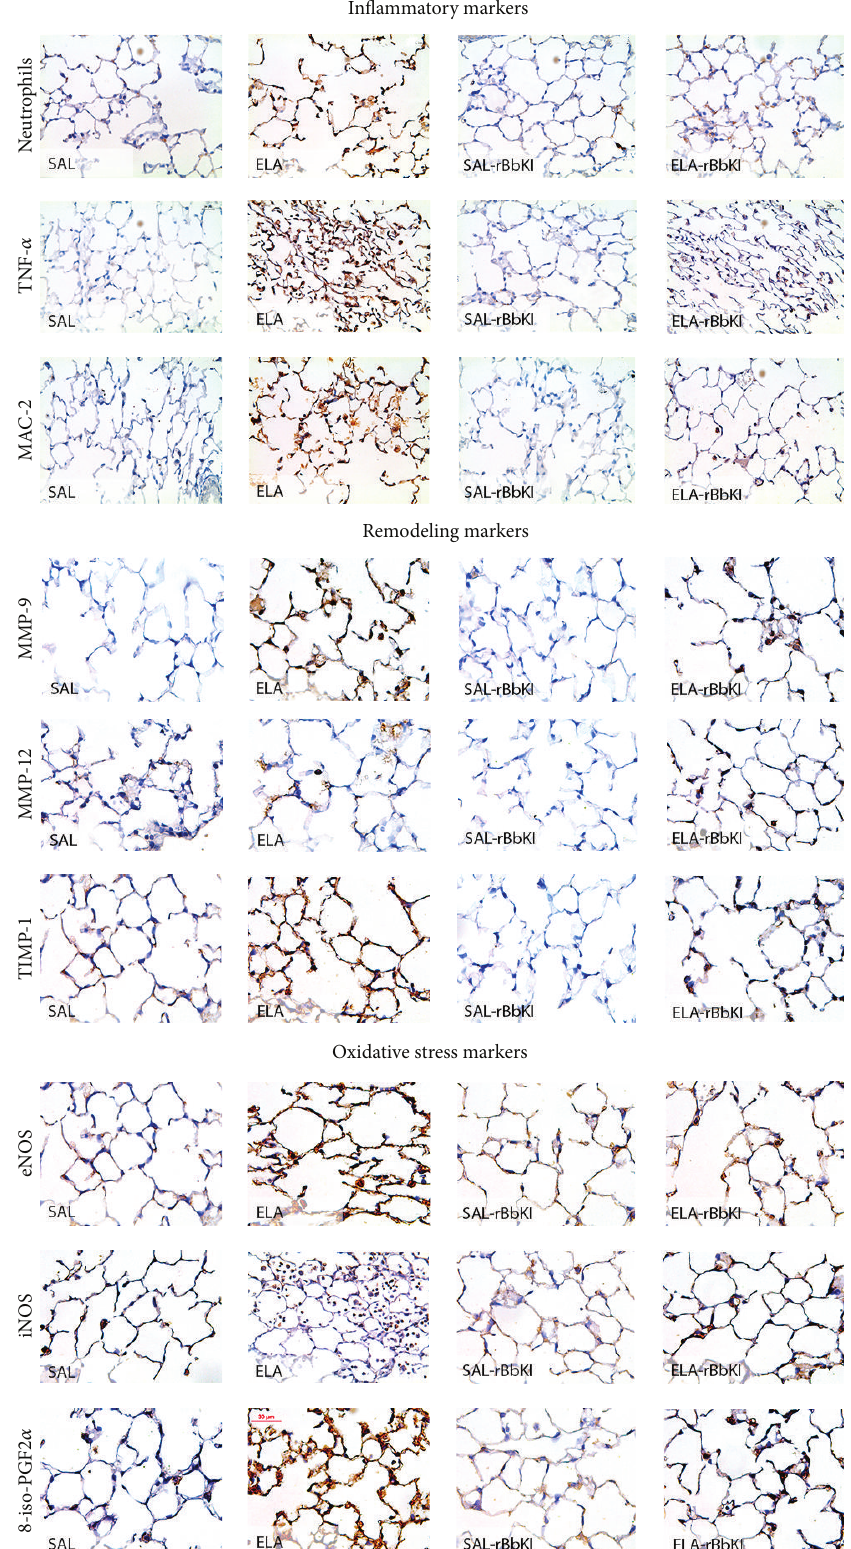
Figure 6: Inflammatory cells, remodeling, and oxidative stress markers in the lung tissue. Magnification of